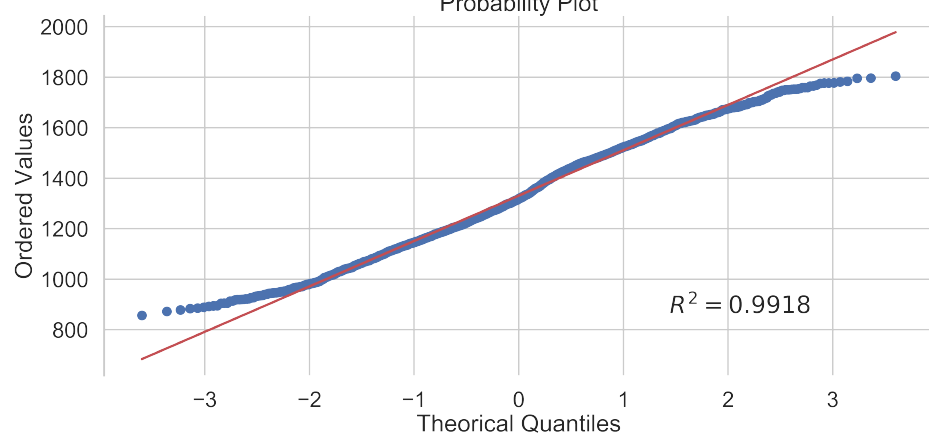
Figure 5. QQ-Plot computed for the target variable.